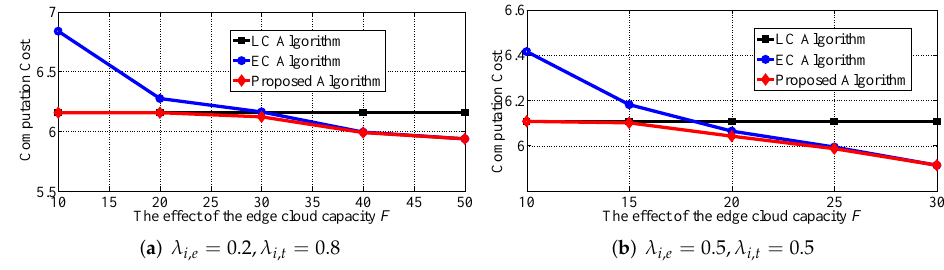
Figure 7. The effect of the edge cloud capacity on the computation